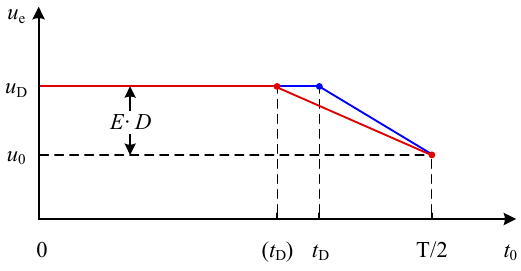
Figure 1. Relationship between arc voltage and AST.